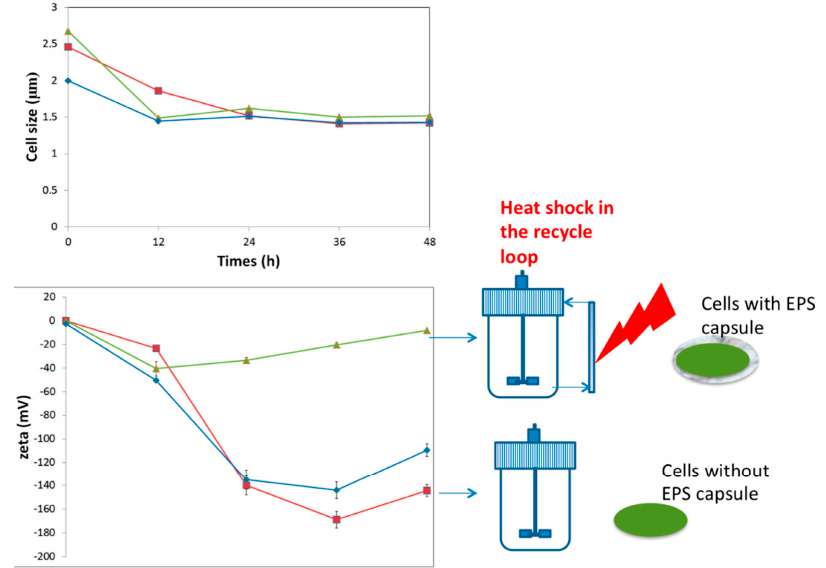
Figure 2. Effect of sub-lethal heat shock (37–42 °C when cells are crossing the recycle loop, two-compartment reactor, see Figure 1) on cell size and zeta potential. Annulation of zeta potential is observed in the case of the bioreactor performed with heat shock. In this case, stress leads to the excretion of an EPS capsule that can be exploited in order to further increase the robustness of the strain during downstream processing operations (adapted from Nguyen [8]). (square: reference, well-mixed bioreactor, diamond: cold-shock two-compartment bioreactor, triangle: heat-shock two-compartment bioreactor).